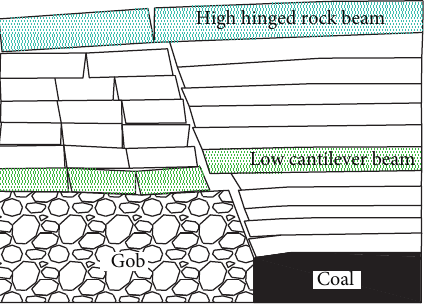
Figure 5: Structure characteristics of low cantilever beam and high hinged rock